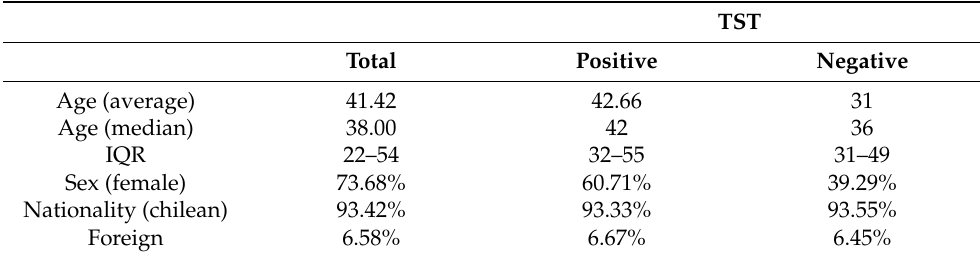
Table 1. Demographic description of patients studied for TST in the Infectious Diseases/Immunology department. (September to December 2022). ( n =